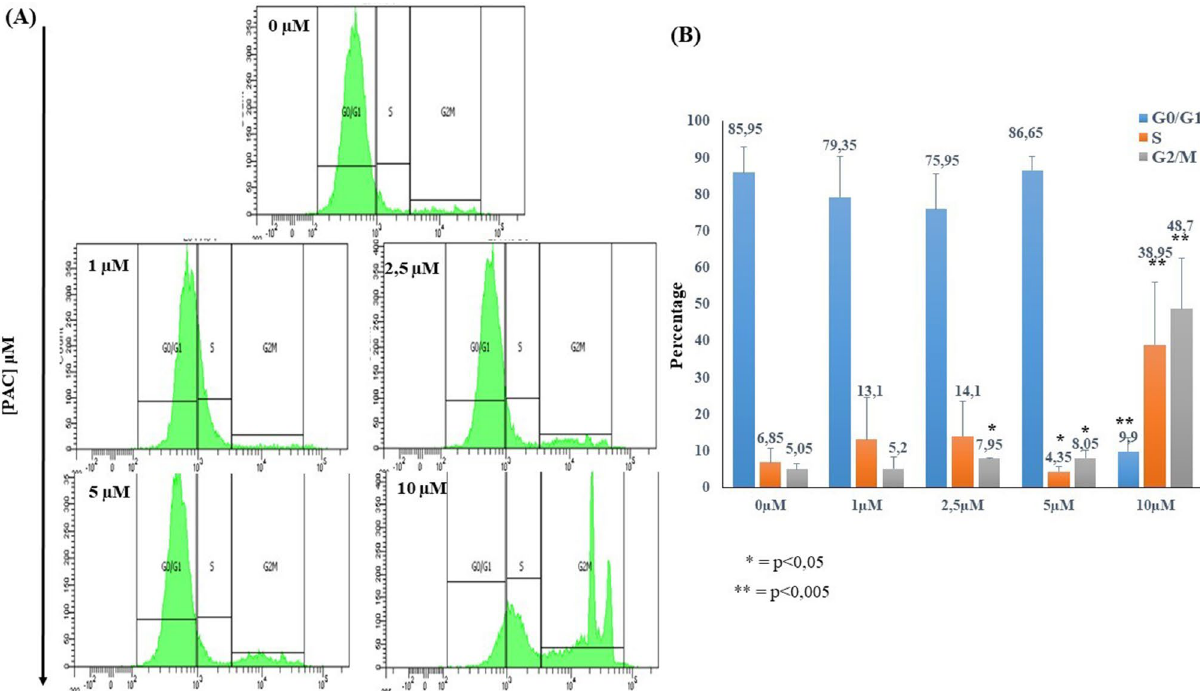
Figure 3. Effect of treatments with PAC on cell cycle distribution in oral cells. ( A ) Cell cycle distribution was evaluated by flow cytometry using the fluorescent DNA dye 7-aminoactinomycin D (7-AAD) (n = 5). ( B ) Statistics analysis of cell cycle distribution in Fig. 3A. Ca9-22 were treated with different PAC concentrations for 24 h. Then, they were responding to PBS buffer before being incubated with 7-AAD . Our results shown that different concentrations of PAC were altering Ca9-22 cell cycle distribution.